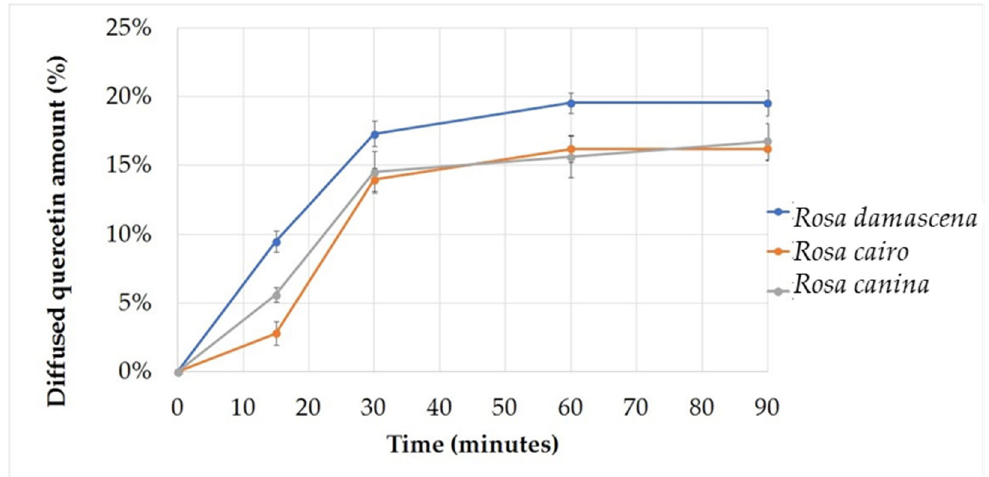
Figure 4. Diffusion profile of formulations without SNEDDS. The maximum amount of diffused quercetin reached 19.54% after 60 min, remaining at the same value after 90 min.